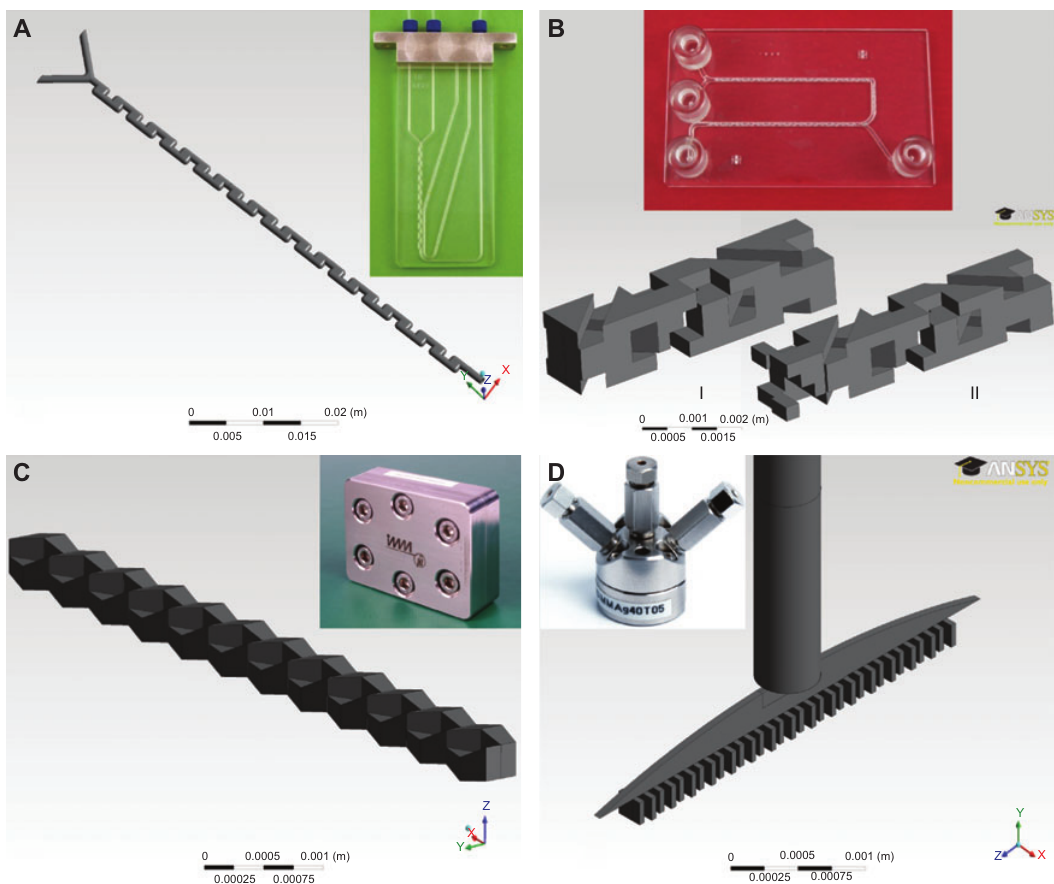
Figure 2 Investigated micromixer. (A) Chicane mixer, (B) ST-mixer, (C) caterpillar mixer, (D) interdigital mixer. The large fi gures show the model domain used in the CFD studies. The insets show the real micromixer.